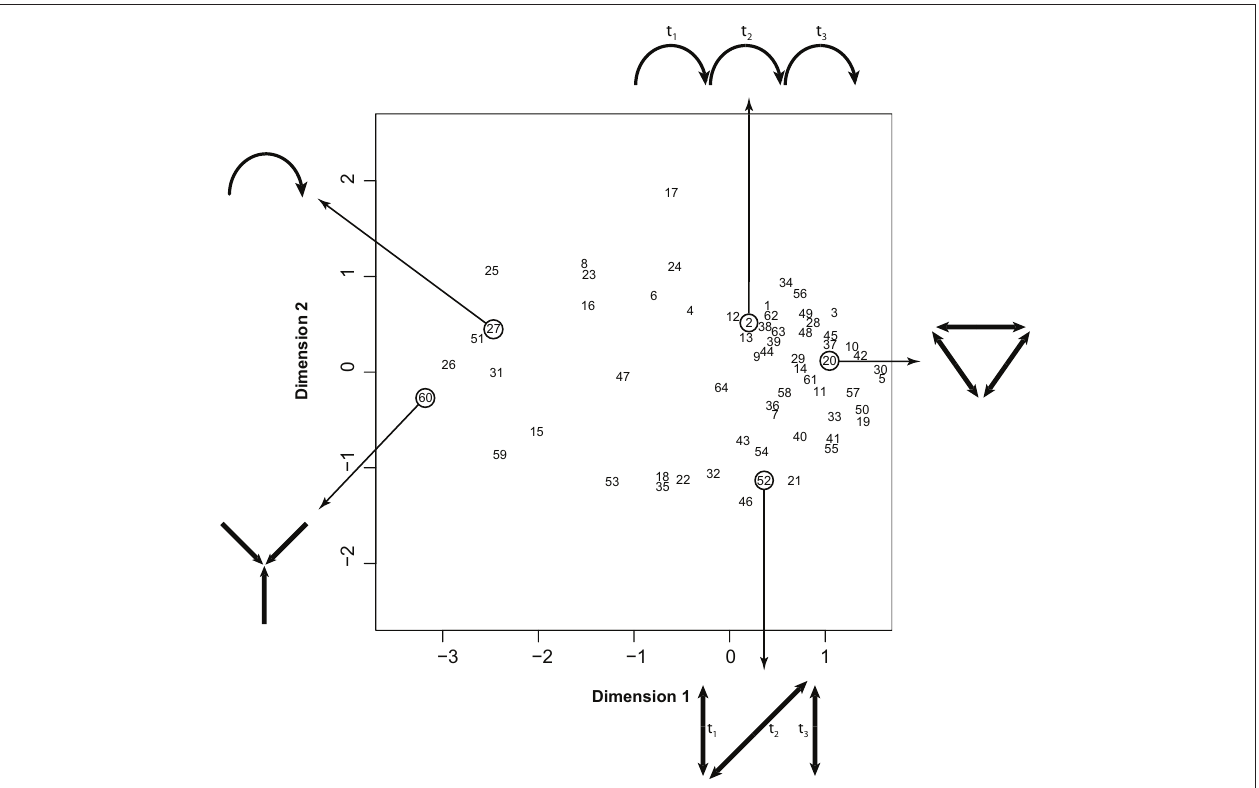
FigurE 5 | Multidimensional scaling solution of the videoclips as categorized across